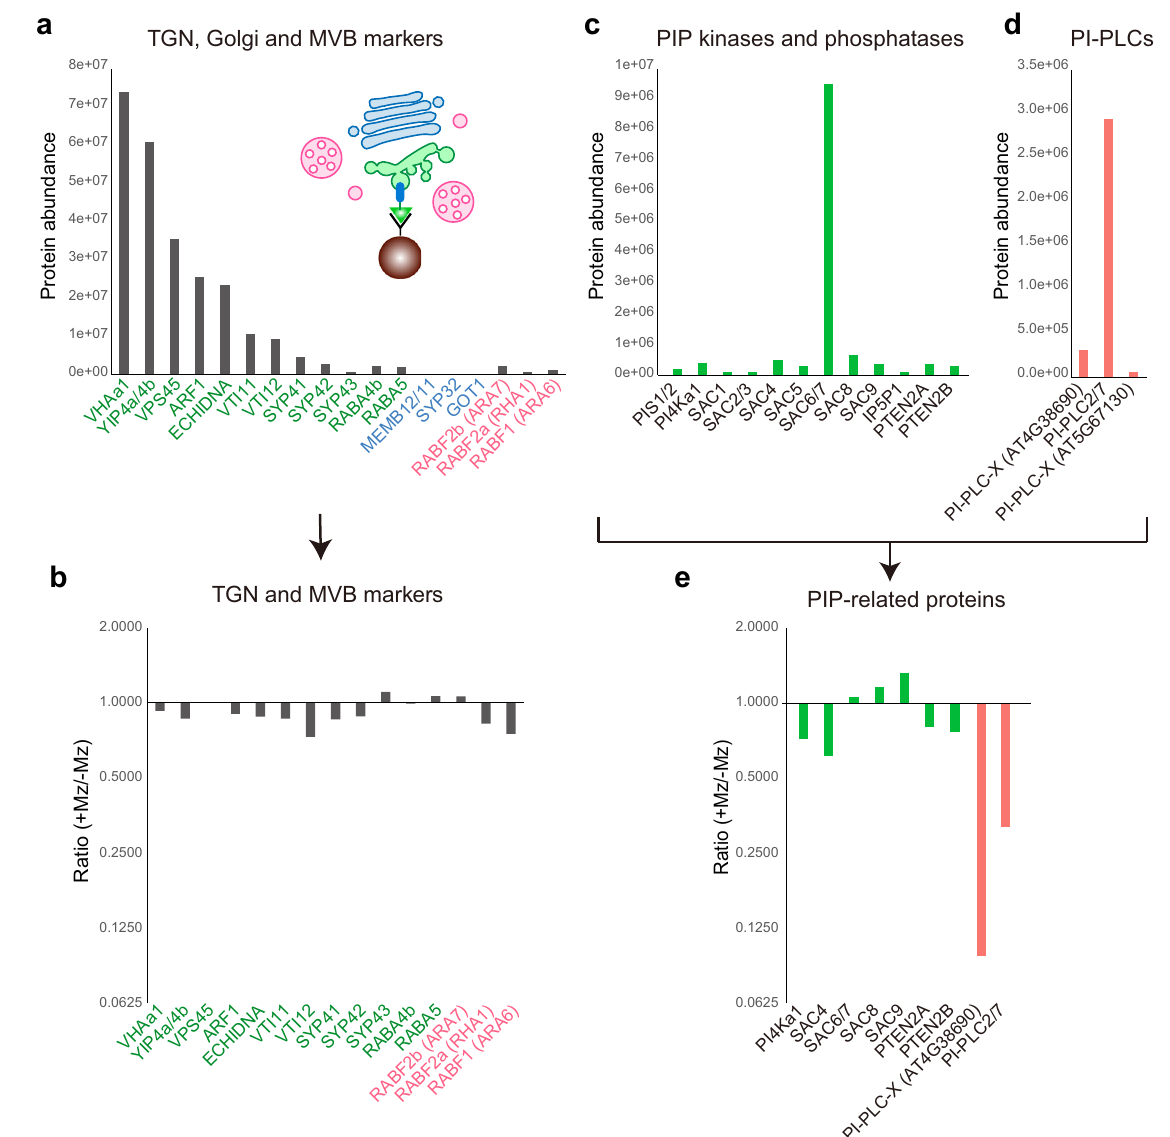
Fig. 8 LC-MS/MS label-free proteomics identi fi ed PI-PLCs as potential target of VLCFAs at TGN. a, c, d, e Protein abundance in SYP61-SVs/TGN immuno-puri fi ed compartments analyzed by label-free quantitative proteomics (detailed analysis is displayed in Supplementary Data 3 and synthesized in Supplementary Data 4, including the number of peptides found for each proteins). a TGN (green), Golgi (blue), and MVB (red) markers, c PIP kinases and phosphatases, d PI-PLCs. The abundance ratio of the proteins shown in a or c, d between control and Mz-treated samples is displayed in b or e , respectively. For the calculation of ratio, we applied a threshold of minimal protein amount as 300,000 to select the proteins from which we can get reliable ratio. TGN markers were abundant compared to Golgi and MVB markers, which indicates an ef fi cient puri fi cation, and their abundance was not affected by metazachlor (Mz) treatment. In contrast, PI-PLCs were strongly reduced upon Mz treatment. n = 4 biological replicates. higher amount of PI4P and PI(4,5)P 2 , suggesting that PI4P and PI to the low signal intensity at dots, we processed the images with a (4,5)P 2 are the in planta substrates of PI-PLCs 51 . PI-PLC is a Gaussian blur fi lter and subtracted the background. The pro- cessed images revealed intracellular dots partly colocalizing with family of nine members in Arabidopsis . Our proteomic results the TGN marker VHA-a1-mRFP (Fig. 10e, Supplementary indicate that PI-PLC2 and PI-PLC7 might act in PI4P home- Fig. 9b). However, due to the low TGN signal in control condi- ostasis at TGN. As PLC2 is a main player in the root, we chose to tion, we could not con fi rm that PLC2 was deprived from TGN focus on PLC2. A previous membrane fractionation study upon Mz treatment. In any case, a lower amount of PI-PLCs at reported that PLC2 is mostly localized at the PM and to a lesser SVs/TGN could result in a higher amount of PI4P at the TGN. extend in the microsomal fraction and small dots inside the cell 51,52 . To check whether PLC2 could localize at TGN, we produced a GFP-tagged version PLC2 driven by the pUB- IQUITIN10 promoter to get strong and uniform expression SLs-mediated PI4P homeostasis involves PI4P consumption by pattern. The signal was mostly localized at the PM but was also PI-PLCs and impacts PIN2 sorting at SVs/TGN . Next, we weakly present in intracellular dots (Supplementary Fig. 9a). Due checked whether increased PI4P level could be due to less PI4P NATURE COMMUNICATIONS| (2021) 12:4267